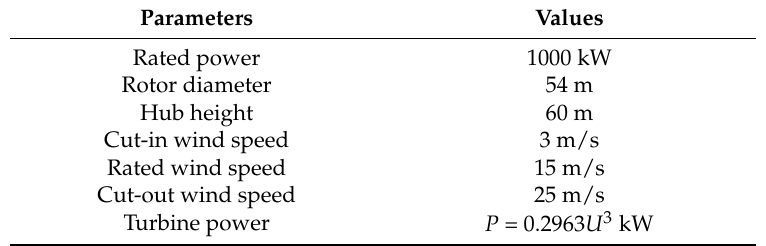
Table 1. Wind turbine model properties installed in the real offshore wind